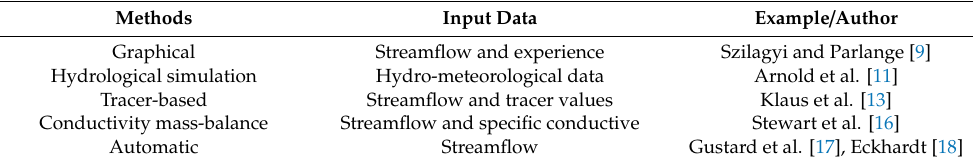
Table 1. Introduction to the commonly used baseflow separation